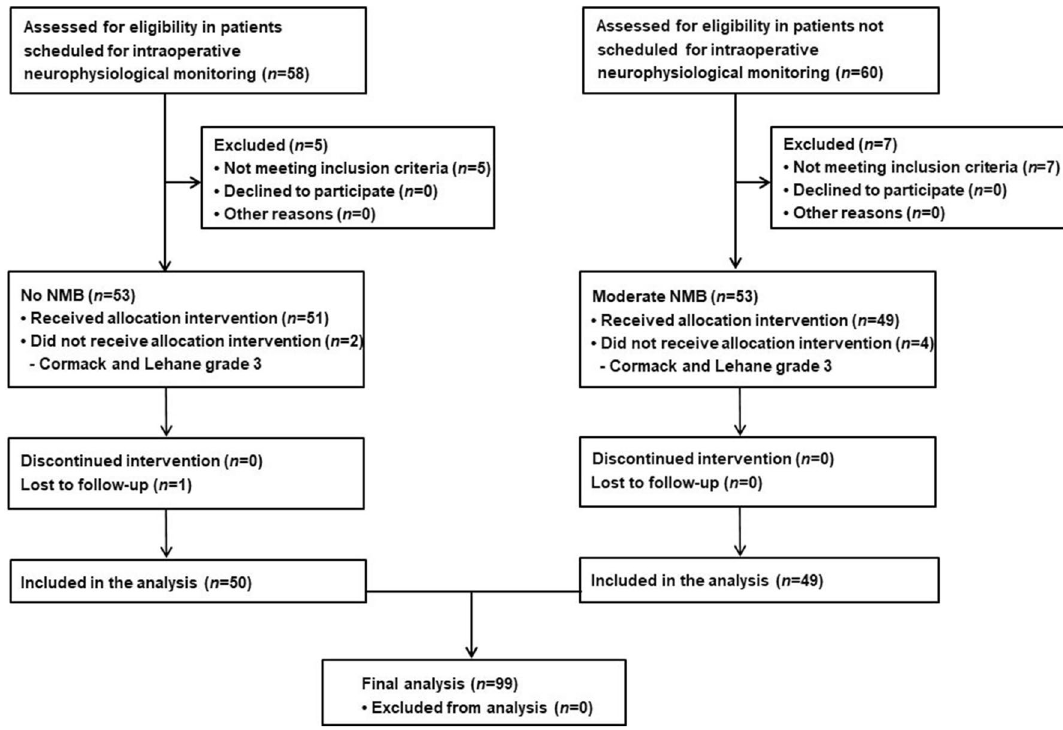
Figure 1. Study flowchart. NMB neuromuscular